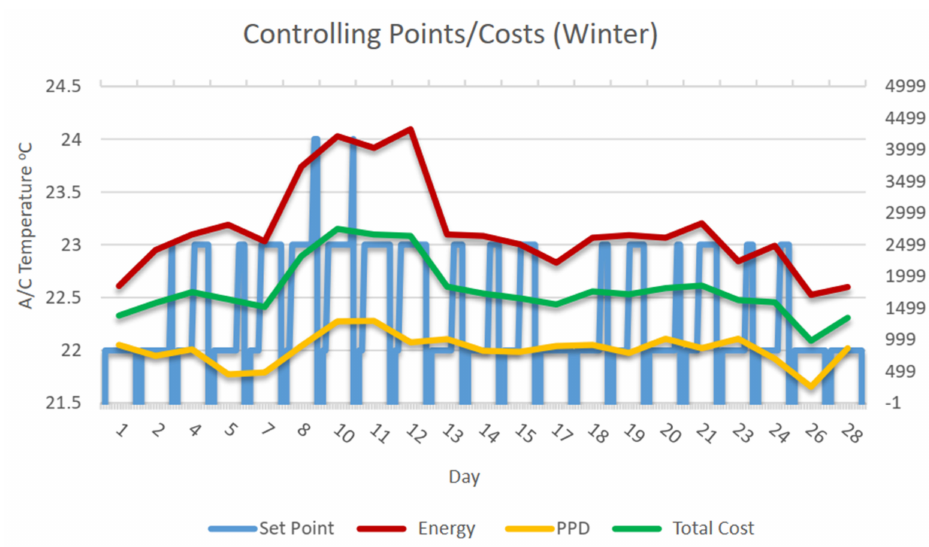
Figure 14. Controlling points and costs